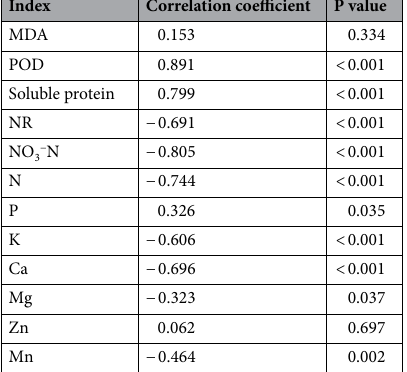
Table 3. Correlations of the investigated indices with NO 2 exposure time. MDA, malondialdehyde; POD, peroxidase; NR, nitrate reductase; NO 3− N, nitrate